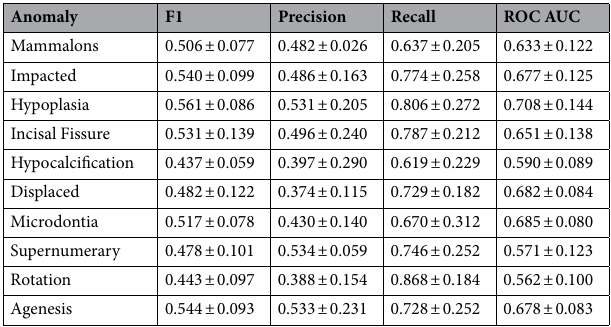
Table 1. Model metrics. Results given are the mean result of all fivefolds with the standard deviation.